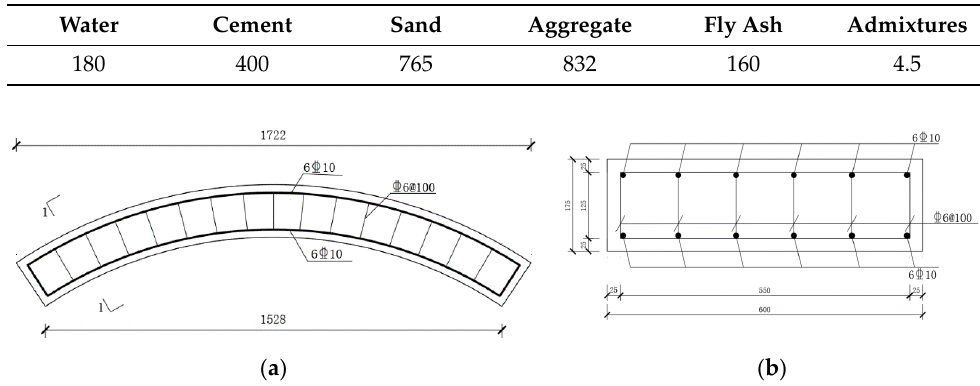
Table 1. Mixing proportion of the concrete (kg/m 3 ).